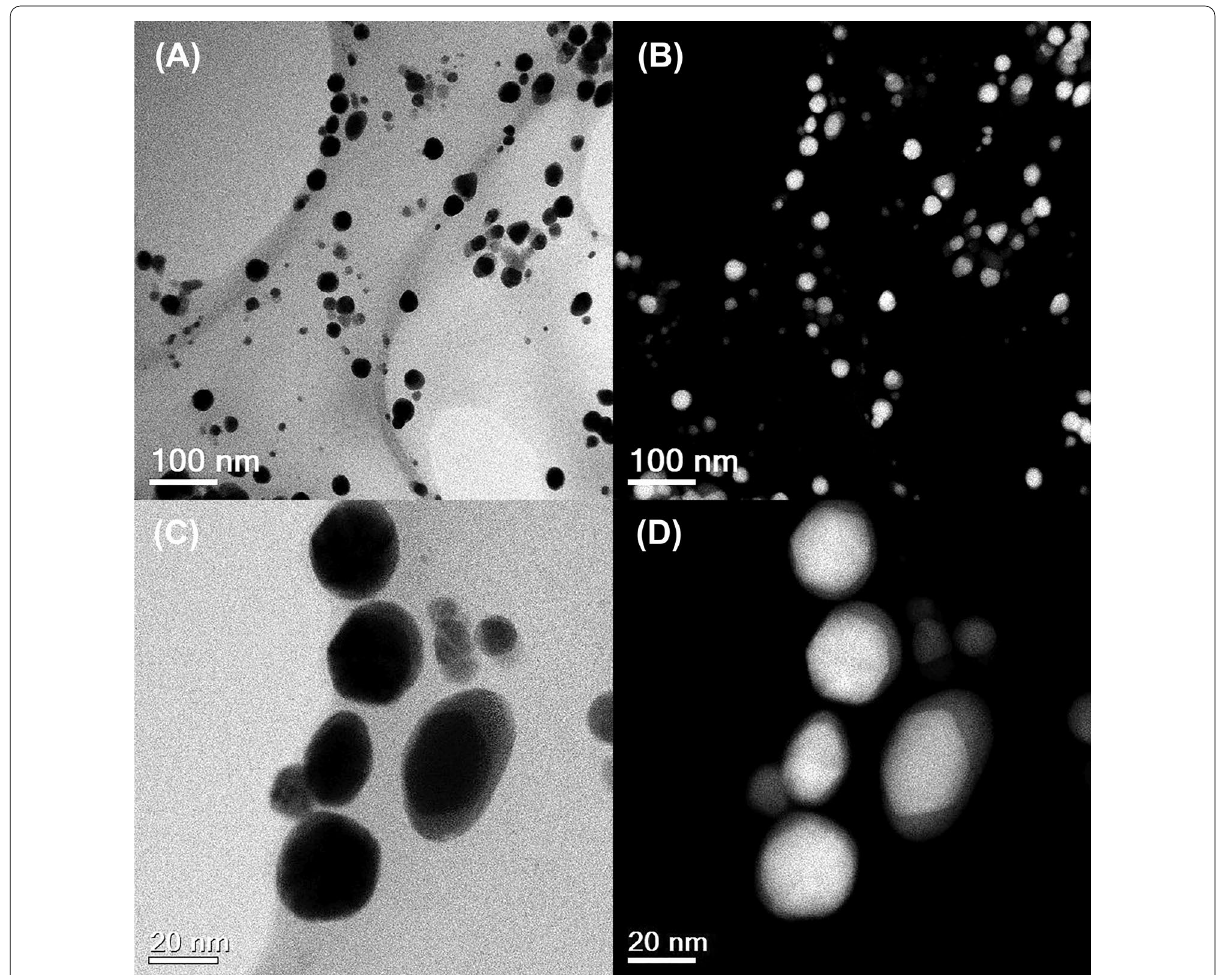
Fig. 3 Scanning Transmission Electron Microscopy at low magnification (scale bar 100 nm) of Au@AgNPs in Bright Field ( a ) and HAADF ( b ). A Small group of Au@AgNPs at higher magnification (scale bar 20 nm) in Bright Field ( c ) and HAADF ( d